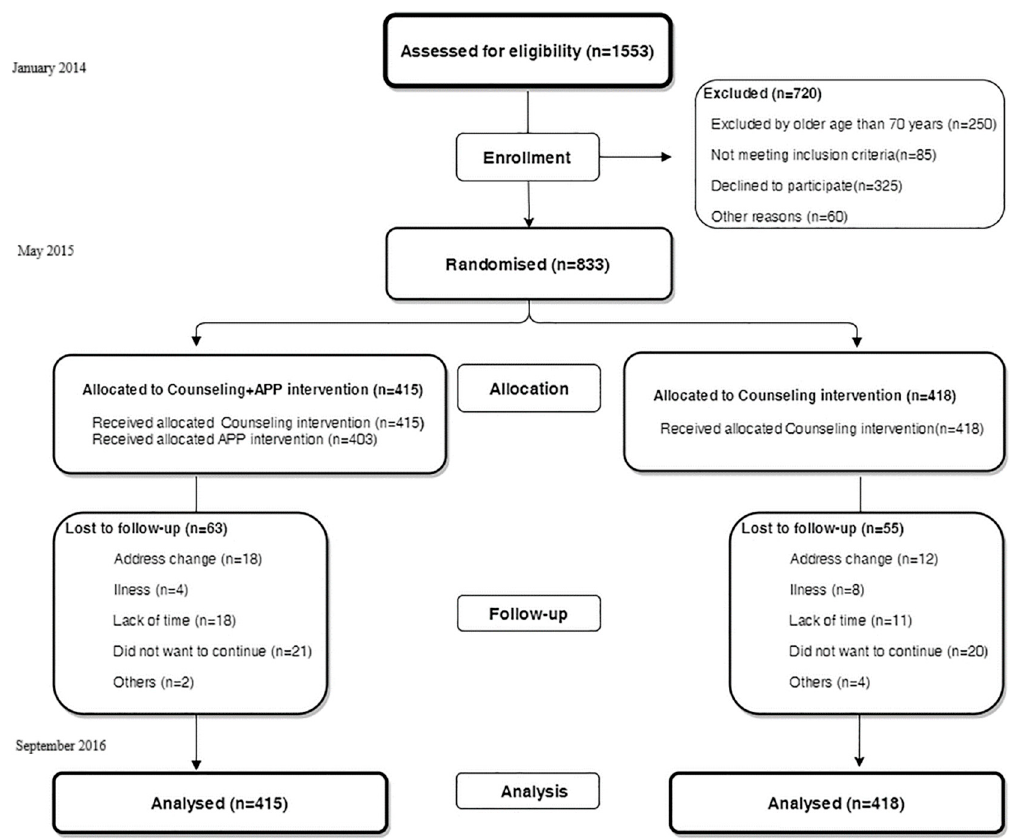
Figure 1. Study flow diagram: enrollment of the participants and completion of the study.